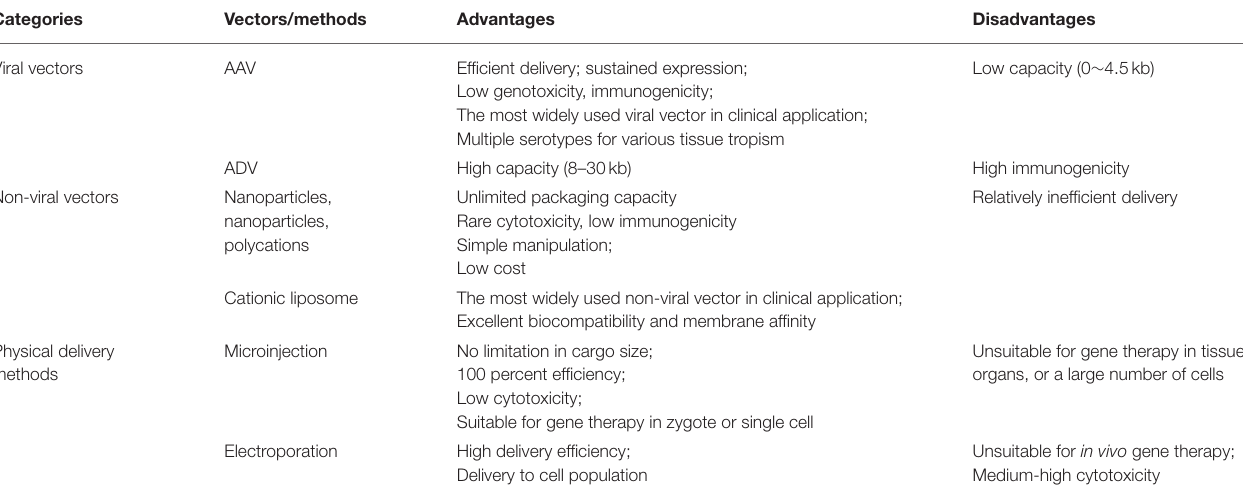
TABLE 4 | Common delivery vectors or methods for gene therapy.